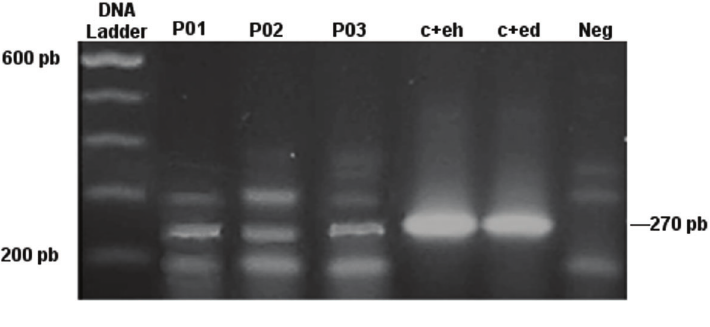
Figure 3. Denaturing gradient gel electrophoresis analysis of stool samples for the identi fi cation of E . histolytica and E. dispar . Lane 1 , positive con- trol of E. dispar; lane 2 , positive control of E. histo- lytica; lanes 3 – 6 , clinical samples; lane 7 , negative